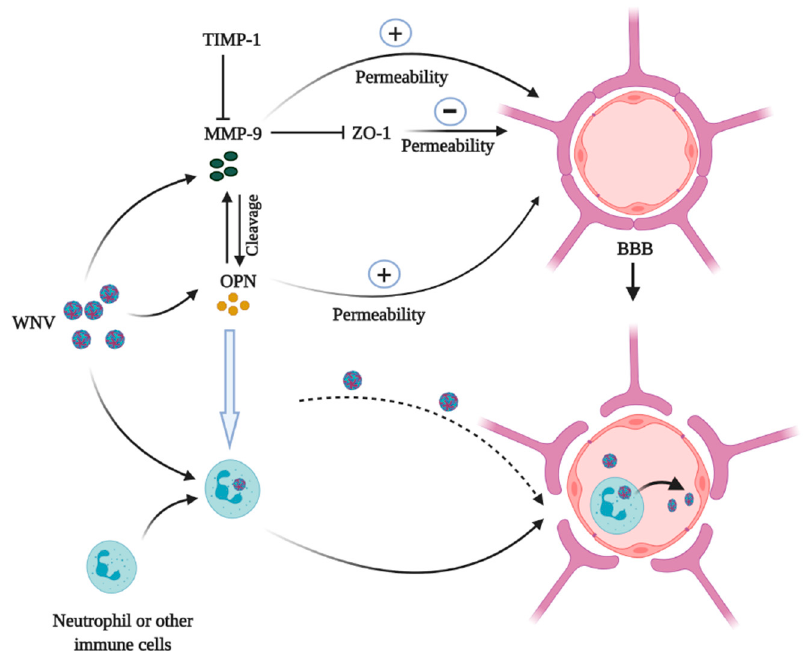
Figure 4. Roles of OPN and MMP-9 in the West Nile virus (WNV) CNS entry. WNV infection induces MMP-9 and OPN expression. MMP-9 stimulates the activity of OPN by PTM cleavage and OPN also stimulates MMP-9 activities. Both OPN and MMP-9 increase the permeability of the BBB during WNV infection. MMP-9 increases the permeability of BBB directly or by inhibiting Zo-1, while TIMP-1 can inhibit MMP-9 activities on the BBB. The increase of the permeability of the BBB facilitates WNV particles to enter into the brain directly crossing the BBB or via neutrophil or other immune cell-mediated “Trojan horse” transportation. Here, OPN increases neutrophil chemotaxis to the site of neuroinflammation. The figure was created in